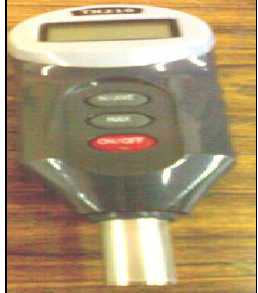
Fig.5: Hardness shore D.